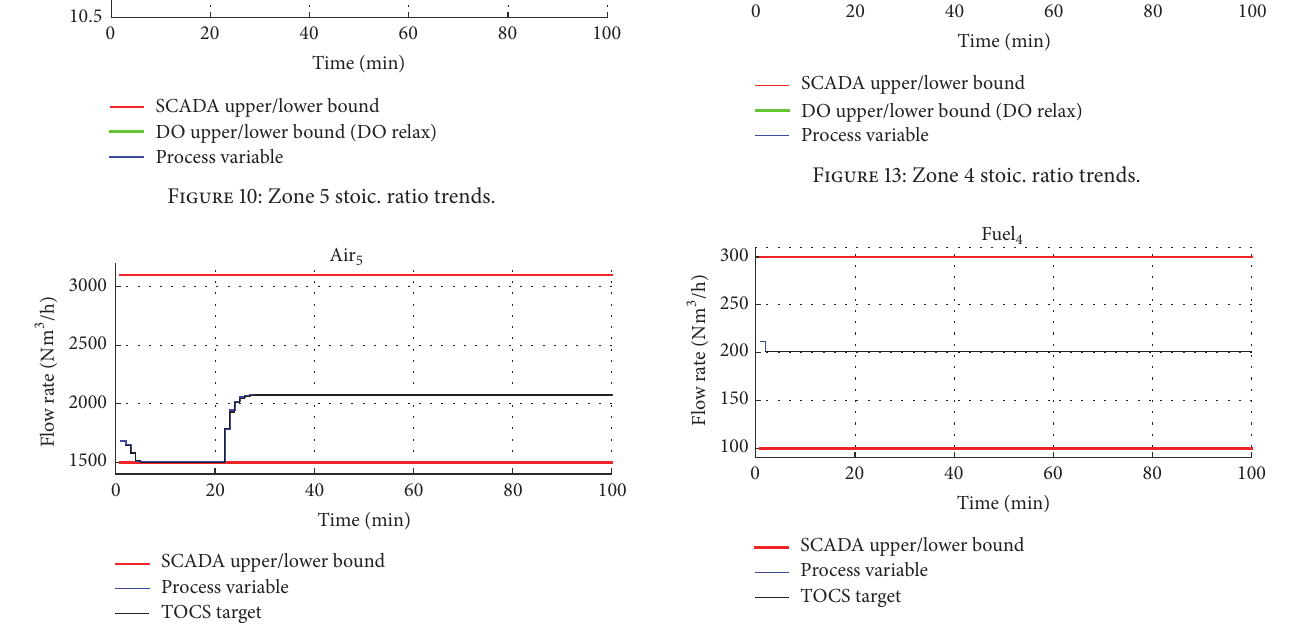
Figure 14: Zone 4 fuel flow rate